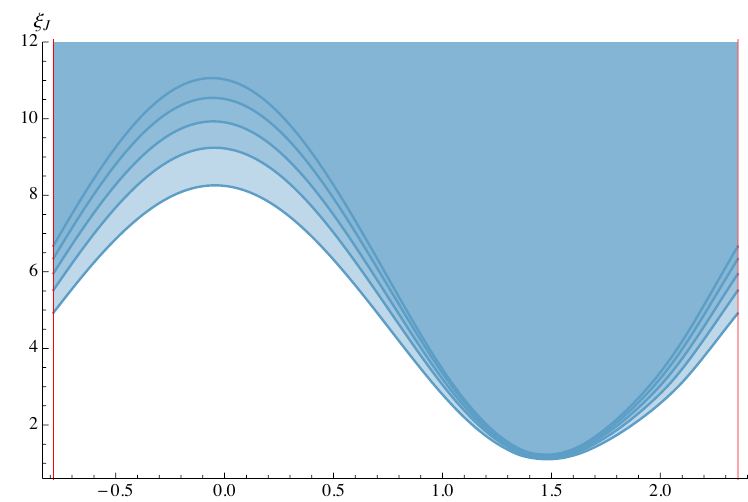
Figure 22 . Left: lower bound on the global symmetry current central charge C J , normalized to the free value, as a function of the parameter (cid:18) de(cid:12)ned in (2.27) for (cid:1) = 1 : 7. On the vertical axis we plot the rescaled central charge (cid:24) J de(cid:12)ned in (6.7). Di(cid:11)erent shading corresponding (from lighter to darker) to (cid:3) = 14 ; 16 ; 18 ; 20 ; 22. The vertical red lines indicates the values (cid:0) (cid:25)= 4 and 3 (cid:25)= 4 which are the extremes of the (cid:18)